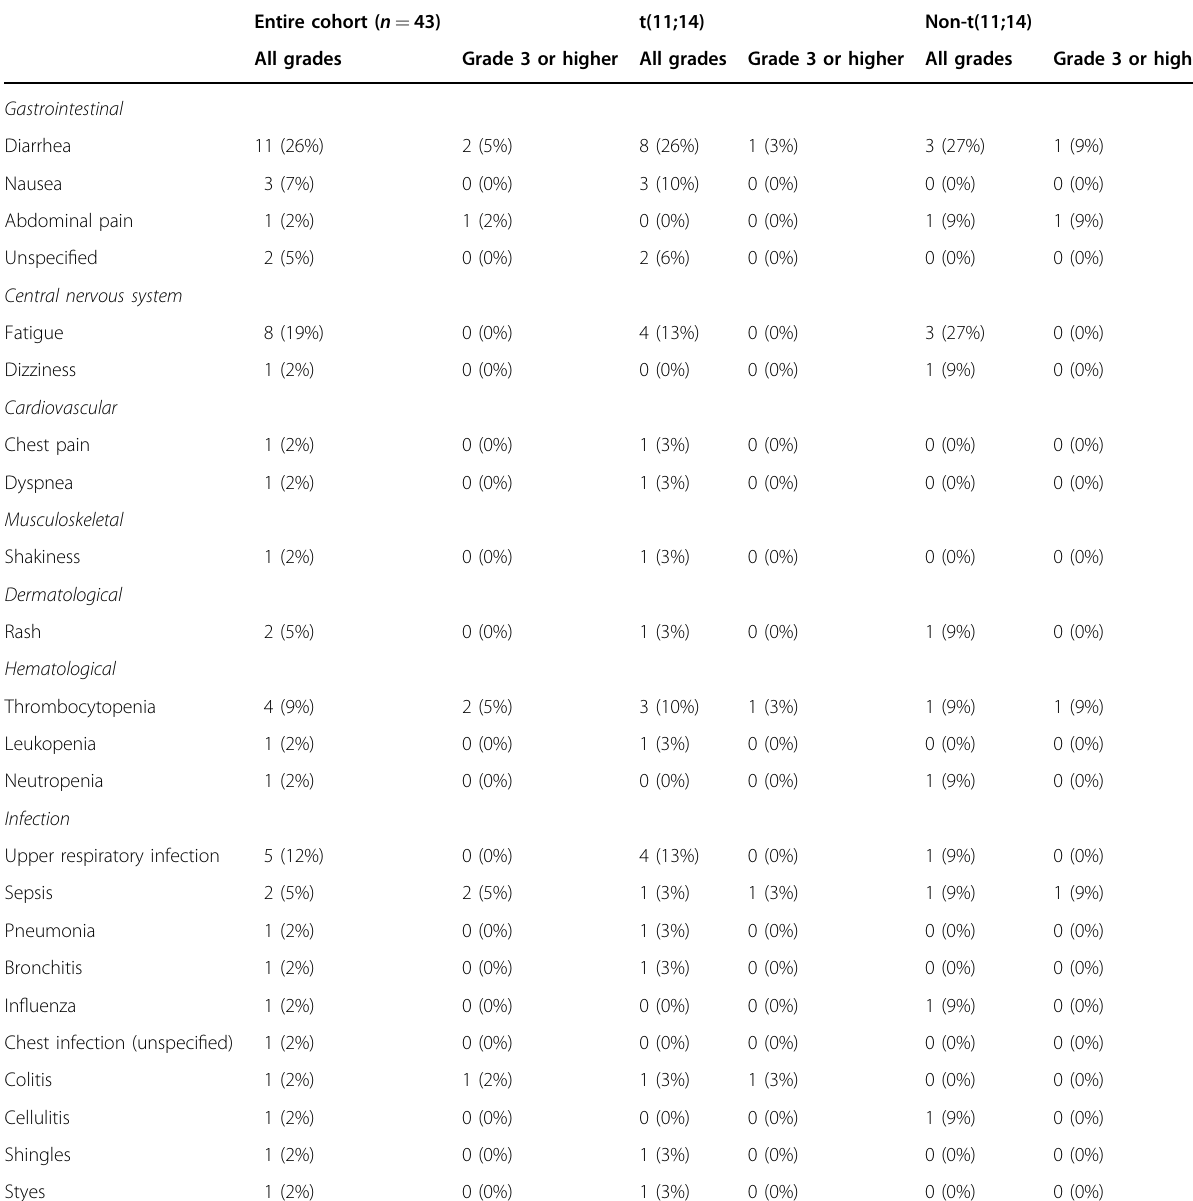
Table 2 Toxicity. Entire cohort ( n = 43) t(11;14)